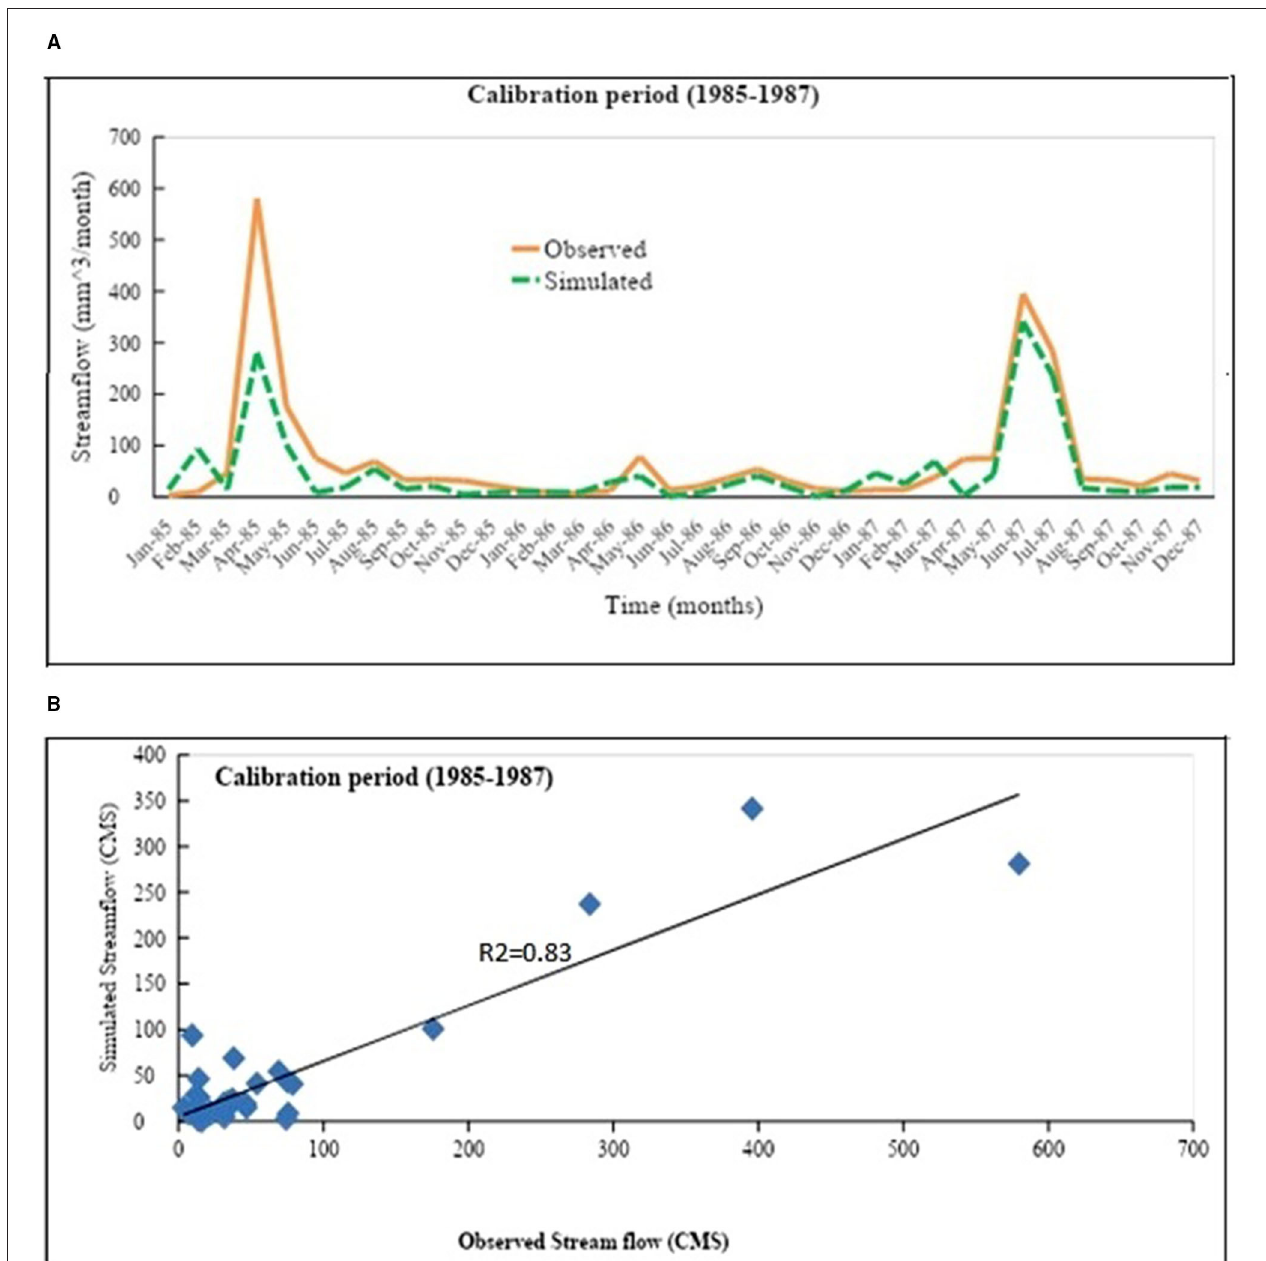
FIGURE 3 | (A) Observed and simulated stream flow during the calibration period at Ewaso Ng’iro (RGS2K01). (B) Regression line during the calibration period at Ewaso Ng’iro